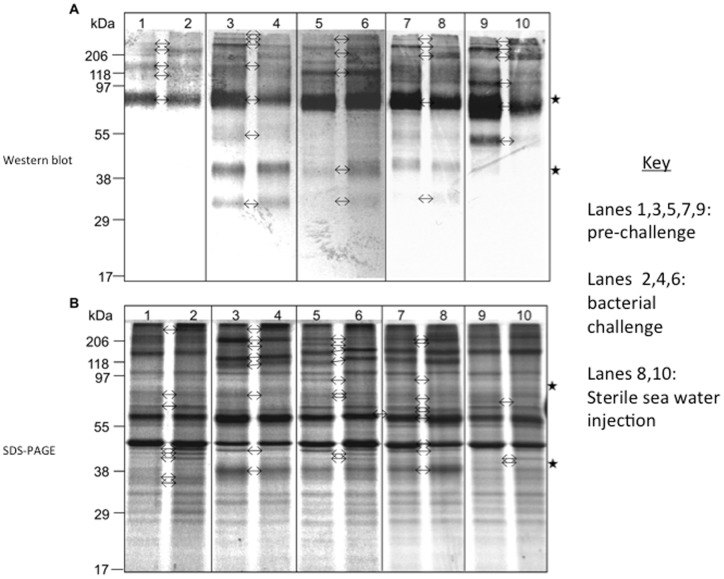
Total coelomocyte proteins from five sea urchins were analysed by Western blotting (A) and SDS-PAGE (B).Coelomocyte proteins were extracted from animals either before (pre-) or after (post-) immunological challenge with heat killed bacteria. Other treatments included injections with filtered sea water (FSW) and injury (pricked with a sterile needle). In both panels A and B, lanes with odd numbers (1, 3, 5, 7 and 9) show pre-challenged protein profiles while lanes with even numbers (2, 4, and 6) show post-challenge protein profiles. Lanes 8 and 10 show the profiles after filtered sea water injection and Injury, respectively. Asterisks to the right of the figures indicate regions that are not stained with Coomassie Blue (B), which contain He185/333
+ bands in the Western blot. A. The Western blot shows a diverse pattern of He185/333 proteins between animals but also changes within individuals before and after immunological challenge, FSW injection and injury. Bands on the blot are not as discrete and sharp as their corresponding bands on the Coomassie Blue stained gel, but appear to be rather diffuse and large. Arrows between pre- and post-challenged samples indicate bands that change in intensity or are present/absent as a result of the experimental treatment. B. The Coomassie Blue stained gel shows discreet, sharp protein bands, some of which differ in size and intensity between animals and within individuals before and after immune challenge. None of the bands, however, could unambiguously be identified as He185/333
+ band when compared to the Western blot.